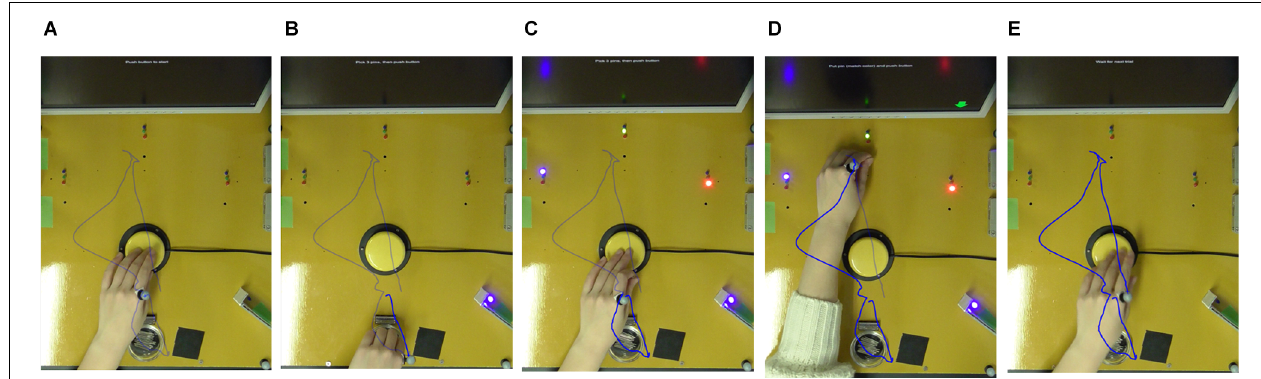
FIGURE 1 | Sequential task. The sequential task was performed as follows. (A) Press the switch with the non-dominant hand. (B) Pick up three pegs in the peg container. (C) After pressing the switch, instructions on where to place the peg are displayed on the monitor. (D) After placing the peg, (E) press the switch to complete one trial. The trajectory of the metacarpophalangeal joint of the index finger of the non-dominant hand is indicated by a blue line.